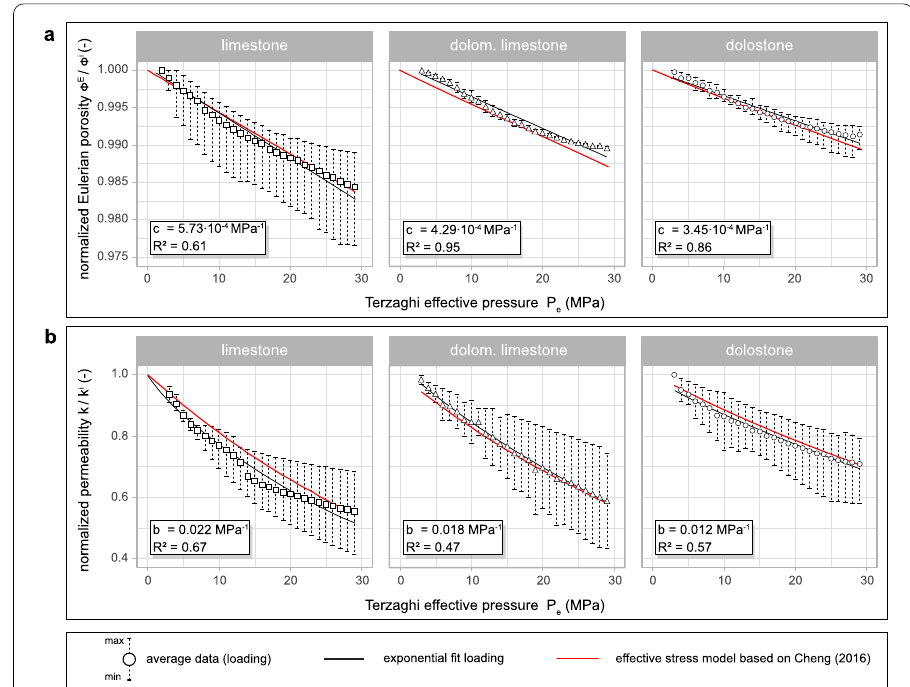
Fig. 14 Normalized porosity ( a ) and permeability ( b ) as a function of Terzaghi effective pressure for different lithologies. The compaction-induced stress sensitivity decreases with increasing dolomitization. The stress sensitivity coefficients c and b were found by best exponential fitting for each group and used as input for the effective stress models. The error bars represent the minimum and maximum values of the measured samples within the specific group—the data points are average